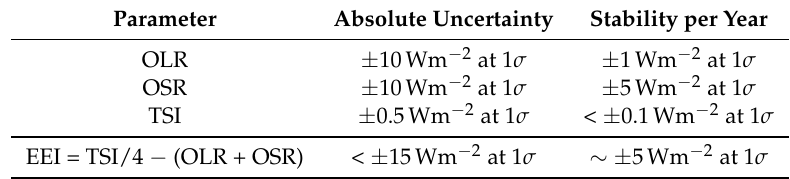
Table 5. ERS scientific requirements. Total solar irradiance is considered as accurately